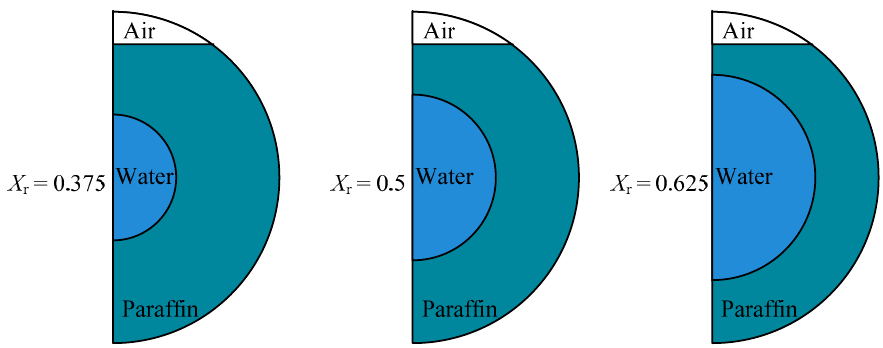
Figure 6. The schematic of the shell-and-tube units for different inner tube diameters.